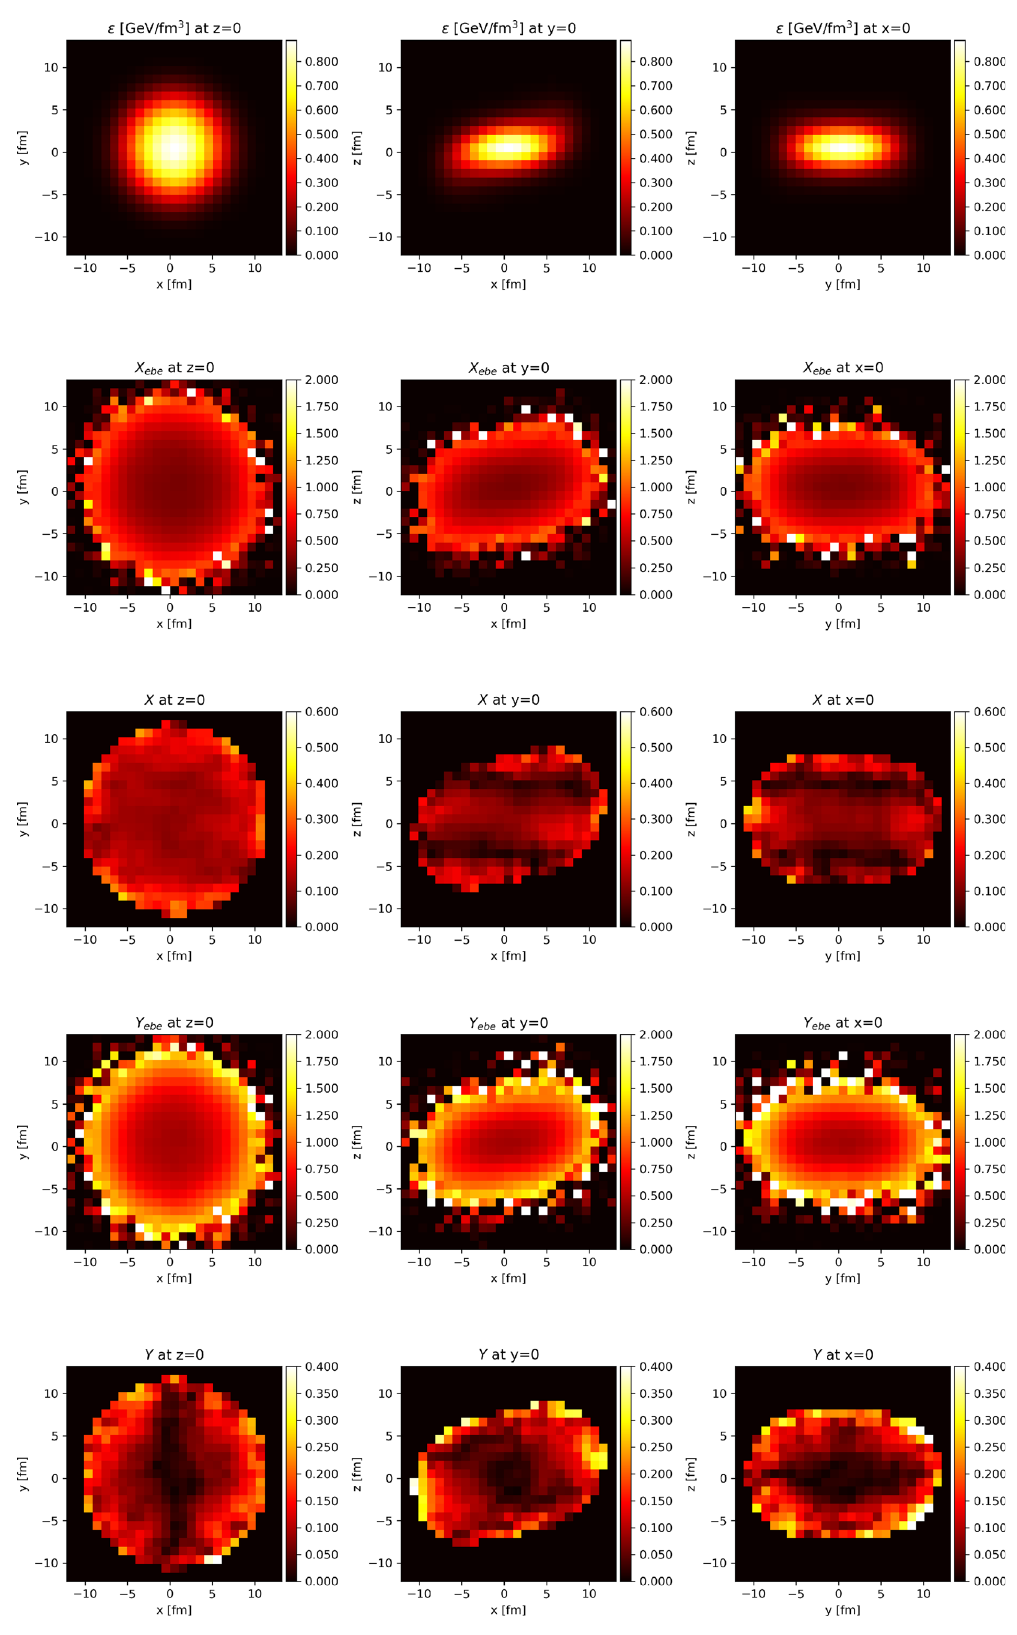
Fig. 11 Au+Au collisions at E lab = 1.23 AGeV, t = 14 fm, 0–5% centrality class, average of 1080 events, distributions along the planes z = 0, y = 0, x = 0 of (from top to bottom): energy density ε , X ebe , X , Y ebe ,